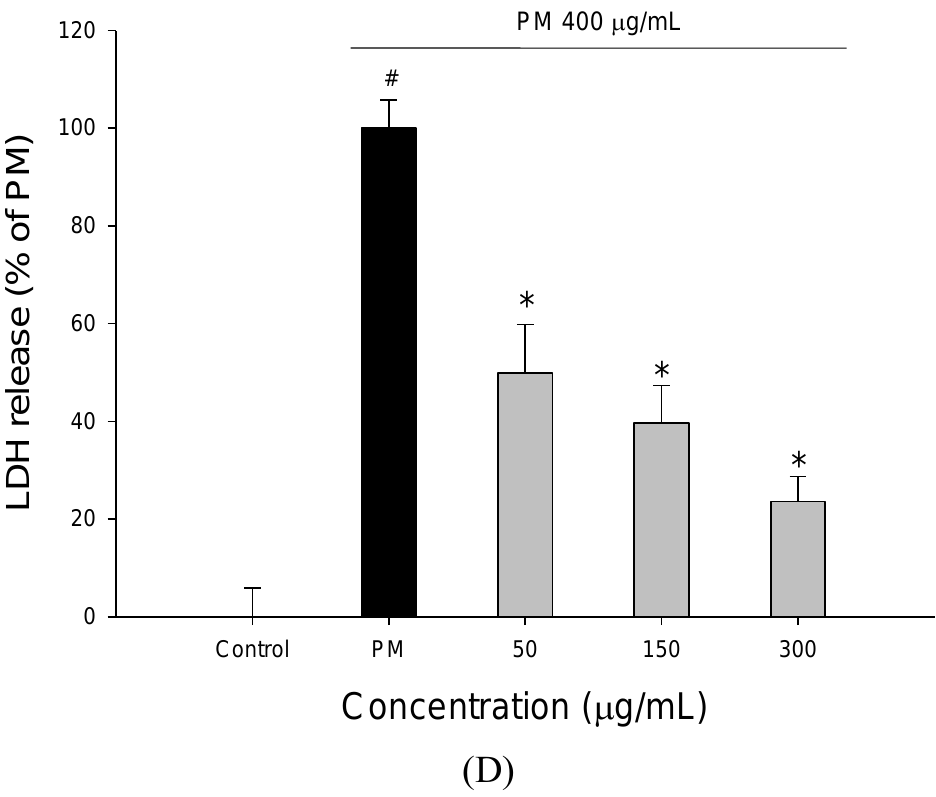
Figure 1 . Effects of water extracts of djulis (WECF) on A549 cell viability induced by particulate matter (PM). ( A ) Effects of different concentrations of PM on A549 cell viability. The cells were treated with PM for 24 h. * ( p < 0.05) compared with the control group. ( B ) Effects of different concentrations of WECF on A549 cell viability. The cells were treated with WECF for 24 h. * ( p < 0.05) compared with the control group. ( C ) Effects of WECF on PM-induced A549 cell viability. The cells were treated with WECF and exposed to 400 µ g/mL PM for 24 h. # ( p < 0.05) compared with the control group and * ( p < 0.05) compared with 400 µ g/mL PM-induced cells alone. ( D ) Effects of WECF on lactate dehydrogenase (LDH) leakage in 400 µ g/mL PM-induced A549 cells. The cells were treated with WECF and exposed to 400 µ g/mL PM for 24 h. # ( p < 0.05) compared with the control group and * ( p < 0.05) compared with 400 µ g/mL PM-induced cells alone ( D ). Data are presented as means ± SD ( n =